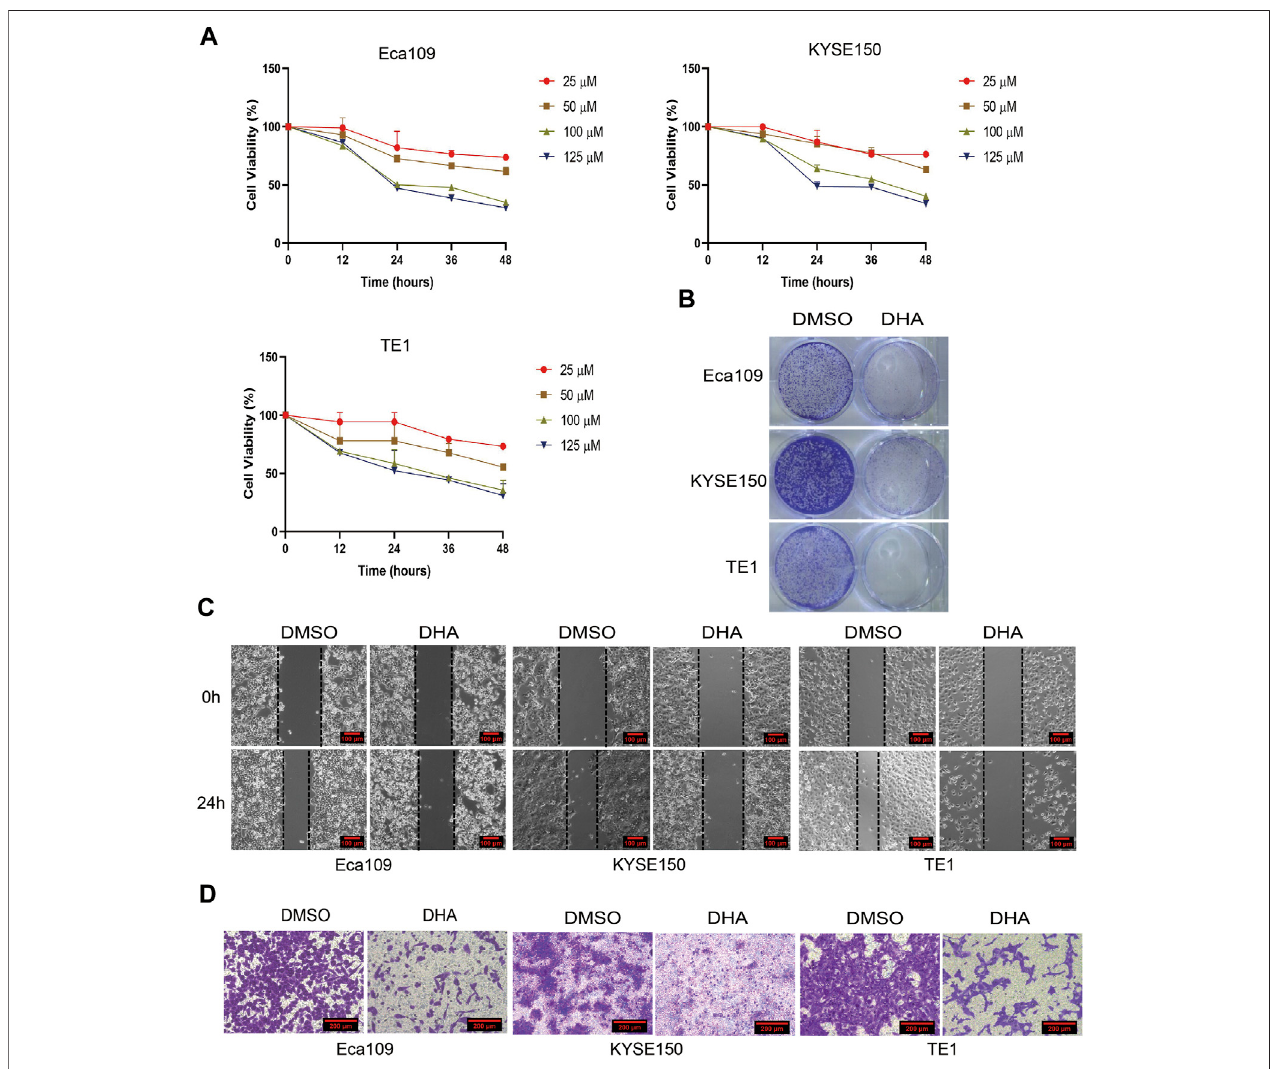
FIGURE 2 | DHA inhibits the proliferation and migration of esophageal cancer. (A) Cell viability of Eca109, KYSE150, and TE1 was detected by CCK8 assay after treated with indicated concentrations of DHA (0,25, 50, 100,125 μ M). (B) Represent images of plate colony formation assay from esophageal cancer cell lines Eca109, KYSE150, and TE1 treated with DHA (100 μ M) or DMSO. (C) Represent images of scratch assay and (D) transwell assay from esophageal cancer cell lines Eca109, KYSE150, and TE1 treated with DHA (100 μ M) or